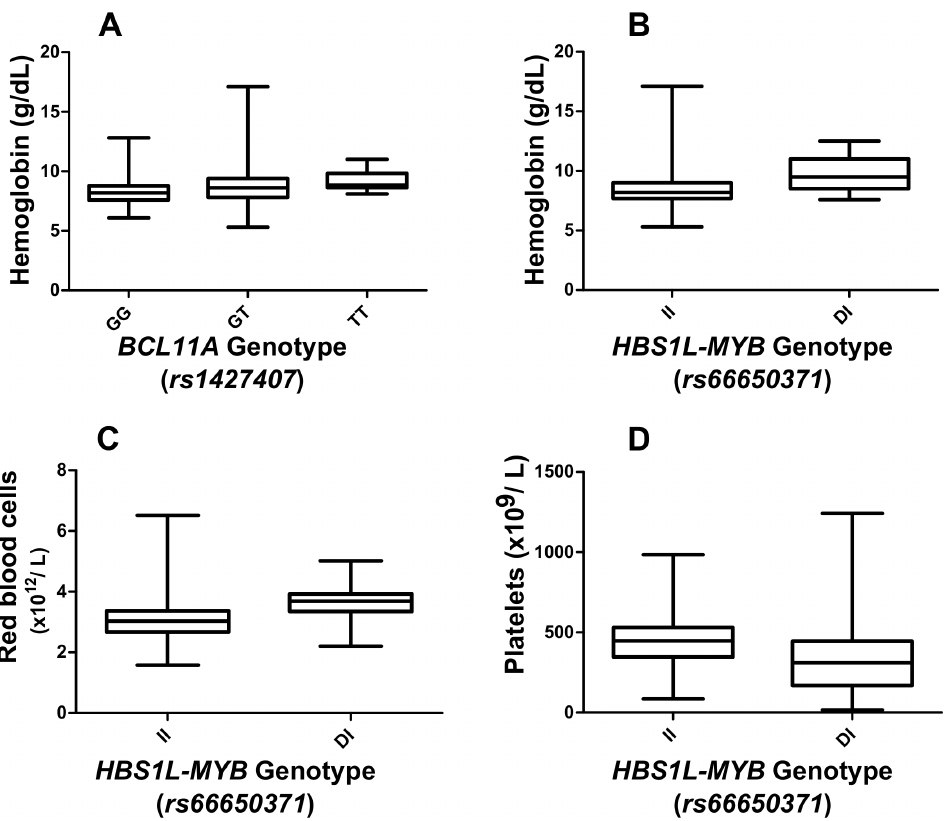
Fig 2. Variants with significant (p < 0.005) impact on haematological variables in our patients. Boxes show the inter-quartile range; the line denotes the median. Whiskers indicate the full range of values observed. Individual p- values are shown in Table 2.